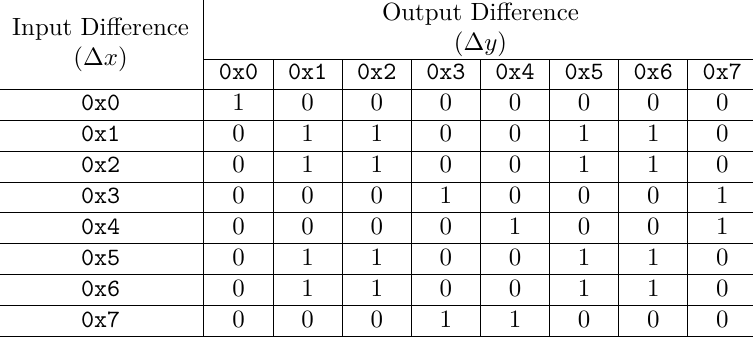
Table 2: The ∗ -DDT of the 3-bit S-box given in Table